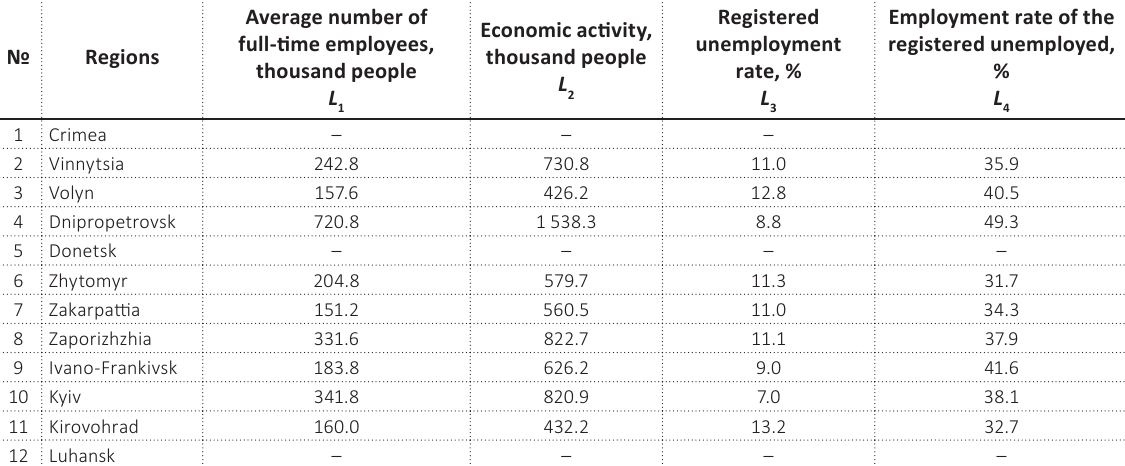
Table C2. Indicators of the provision of Ukraine’s regions with labor resources in